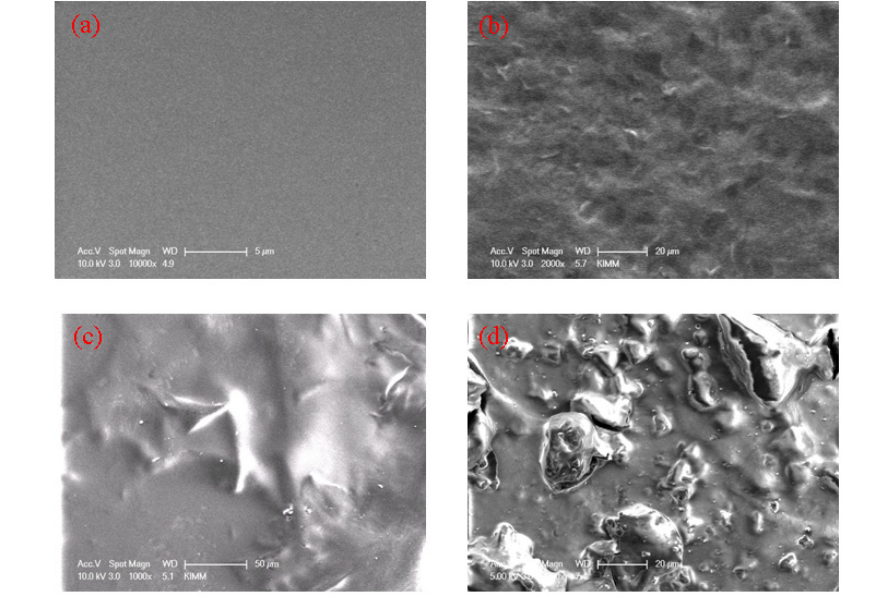
Figure 4. SEM images of ITO glass (a), chitosan-ITO glass (b), tyrosinase-chitosan-ITO glass (c) and MWNT ionic liquid electrode (d)